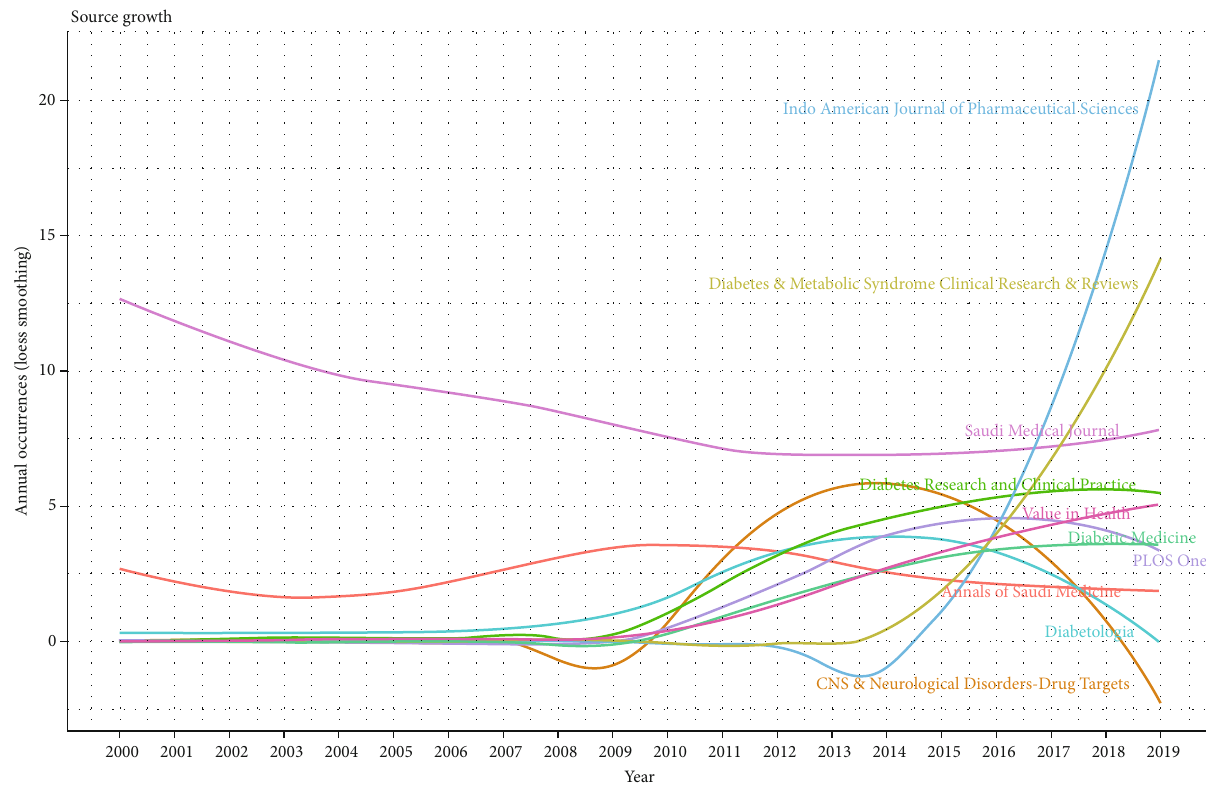
Figure 4: Year-wise growth of 10 most productive